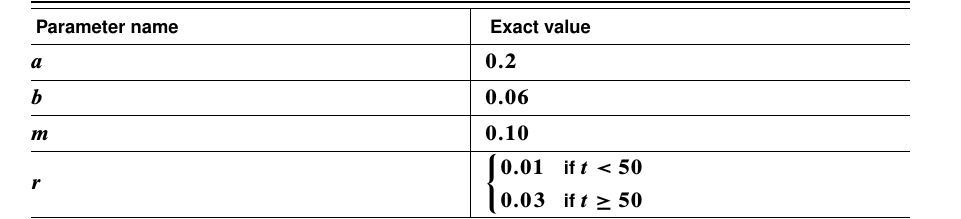
Table 2. True values of the unknown parameters in